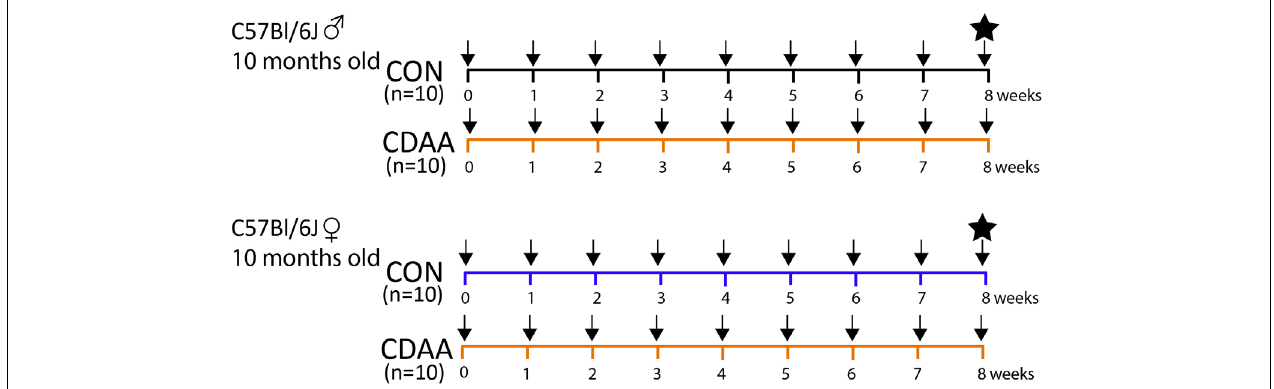
FIGURE 1 | Experimental protocol. Ten-months-old male and female C57Bl/6J mice ( n = 10) were fed with CDAA or CON diet for 8 weeks. Black arrows indicate weekly body weight measurements. The black star indicates the termination of mice in the 9th week, when blood and organ samples were collected. CDAA, Choline Deficient L- Amino acid-defined diet; CON, control